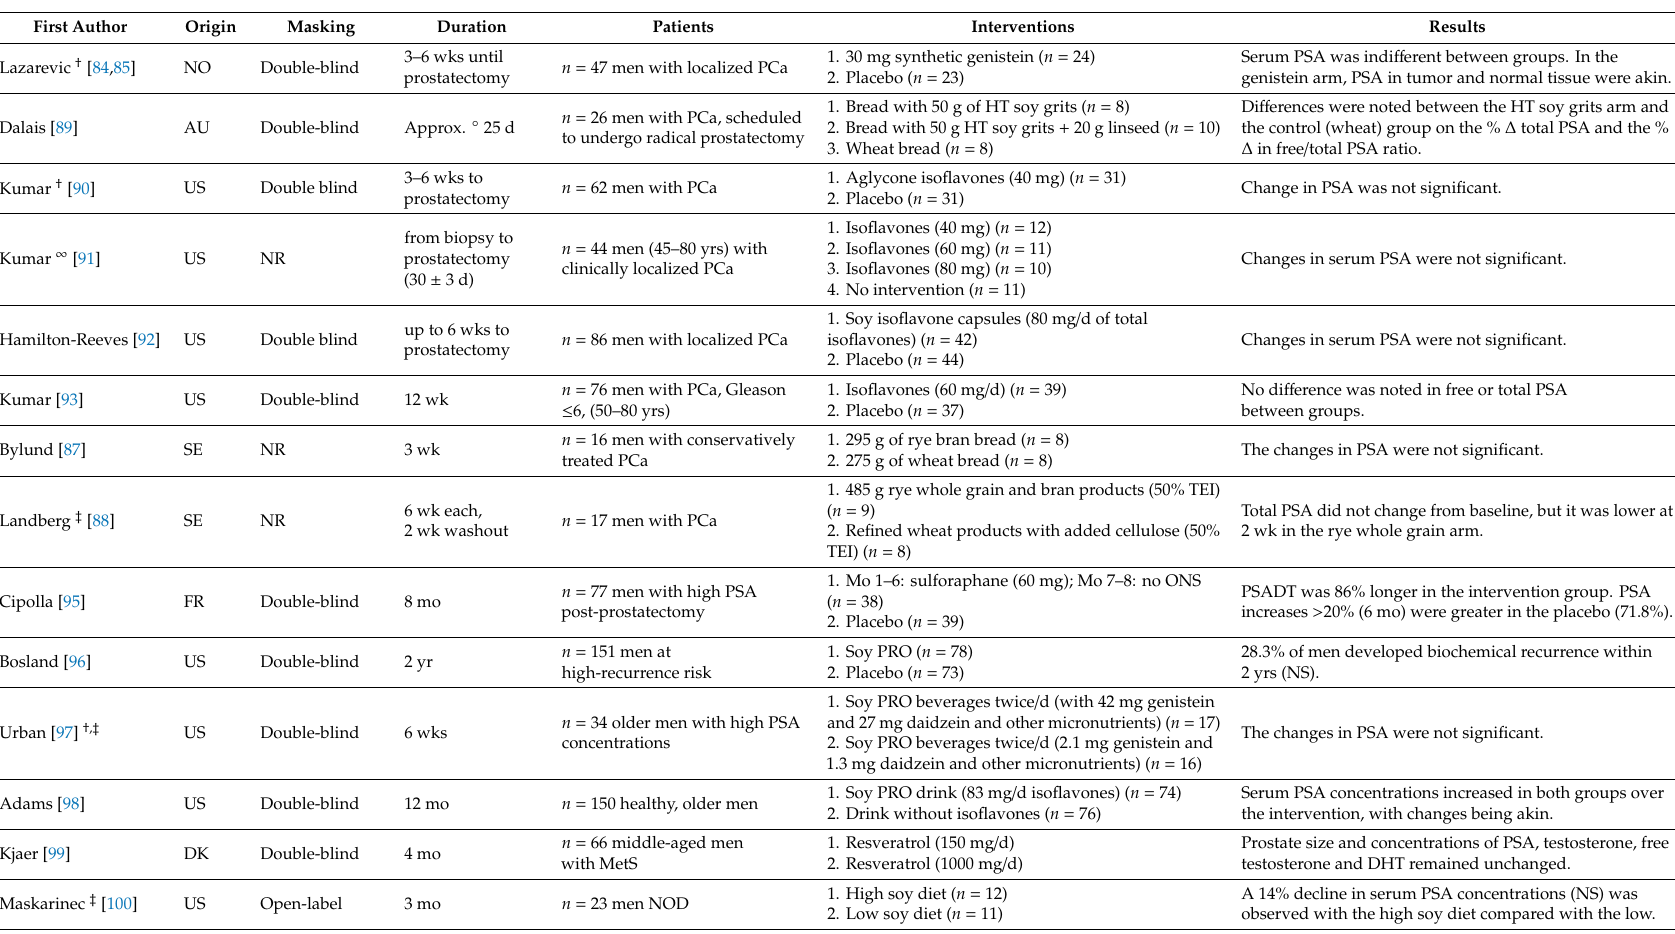
Table 4. RCTs examining the e ff ect of phytoestrogen ONS on PSA concentrations among men with PCa, or increased PCa